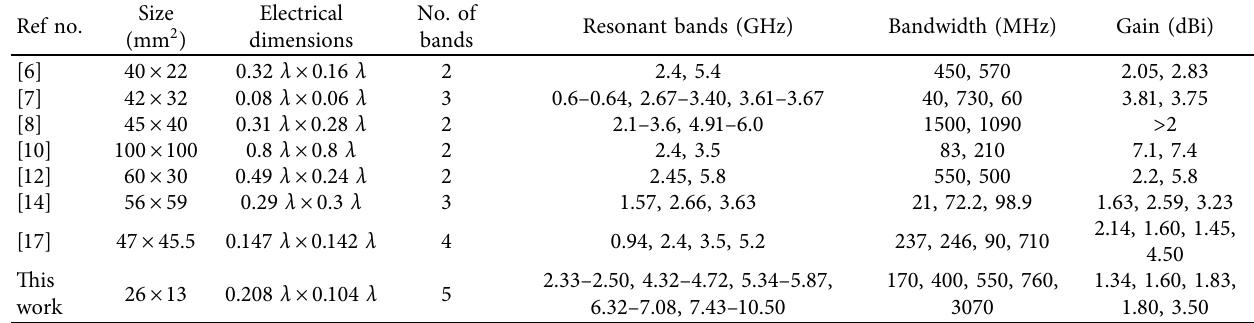
Table 5: Performance comparison with relevant previous